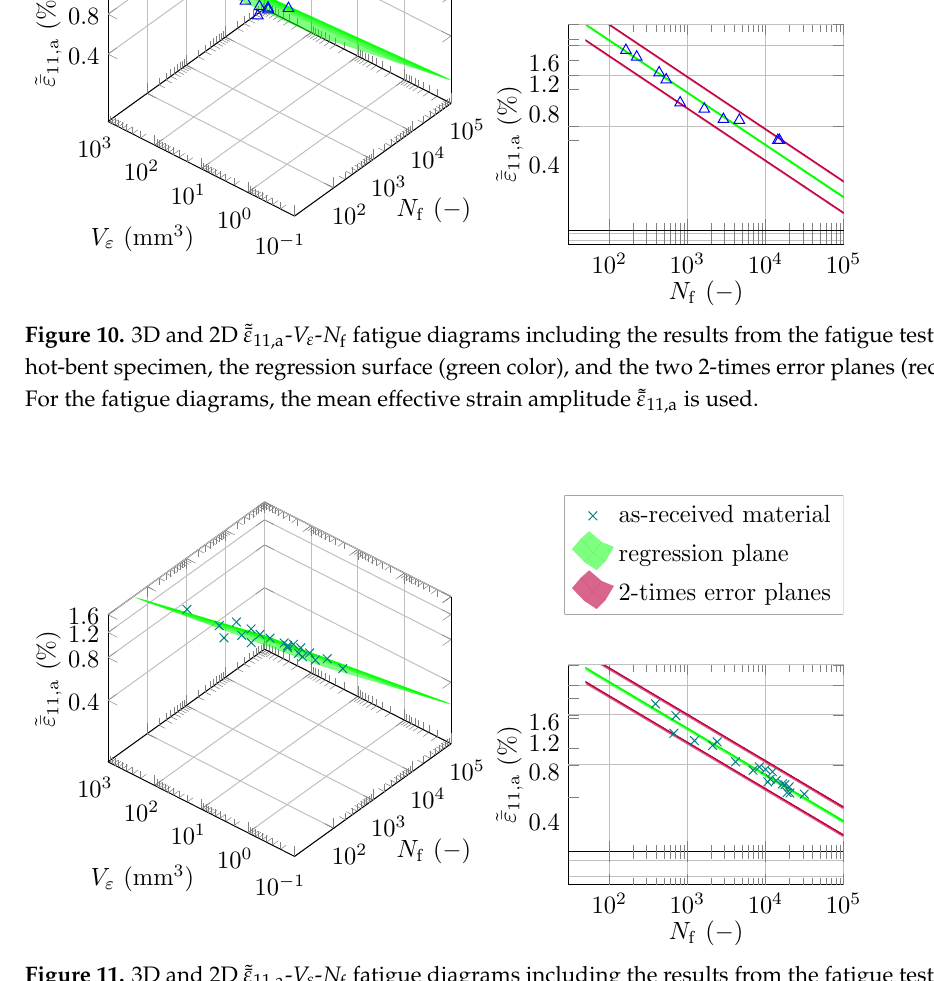
Figure 11. 3D and 2D ˜¯ ε 11,a - V ε - N f fatigue diagrams including the results from the fatigue tests of the as-received specimen, the regression surface (green color), and the two 2-times error planes (red color). For the fatigue diagrams, the mean effective strain amplitude ˜¯ ε 11,a is used.